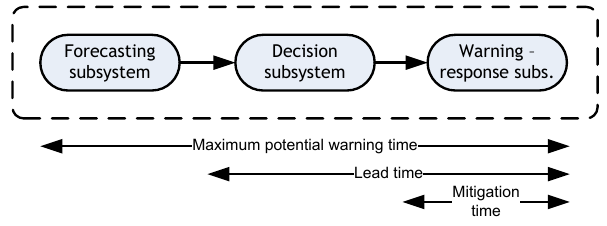
Fig. 1. Flood forecasting, warning and response system (FFWRS) sub-systems. Adapted from Parker and Fordham (1996) and Carsell et al.